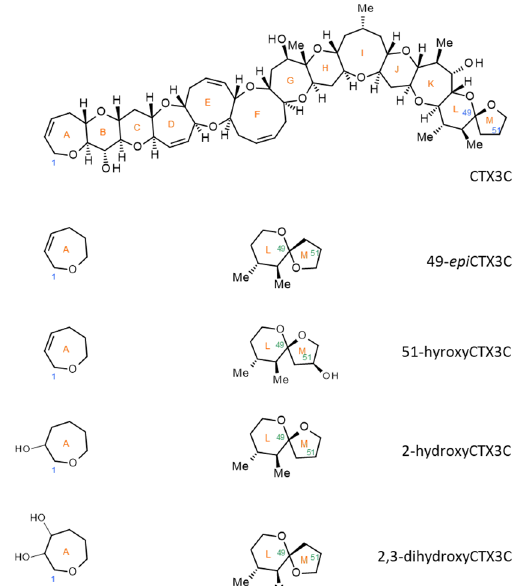
Figure 2. Location of the Ryukyu Islands, Japan, where Variola louti specimens were collected. ( a ) Location of the Ryukyu Islands; ( b ) Expansion of the red rectangle in ( a ). Numbers in parentheses indicate the number of specimens collected from each area.